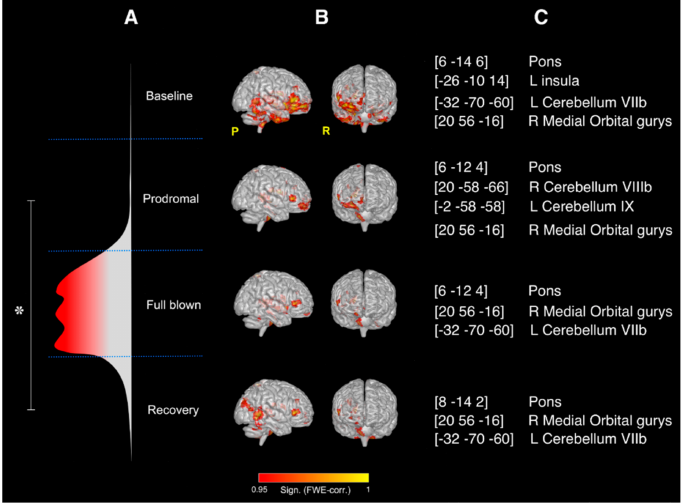
Figure 3. Results of the SCA analysis: right thalamus. ( A ) Flow chart of the study and representation of the different phases of the NTG-induced headache attack; overall significant changes (* FWE- corrected p < 0.05) in the rcFC values were only observed between the prodromal and the recovery SCA maps obtained using the right thalamus as seed area; ( B ) mean effect whole-brain intrinsic connectivity maps for seeds placed in the right thalamus during the four MRI scans of the study (i.e., the four phases of the NTG-induced headache attack) with relative significance (FWE corrected); ( C ) MNI coordinates (x,y,z) of the centroids and anatomical location of the major clusters of each mean effect map in